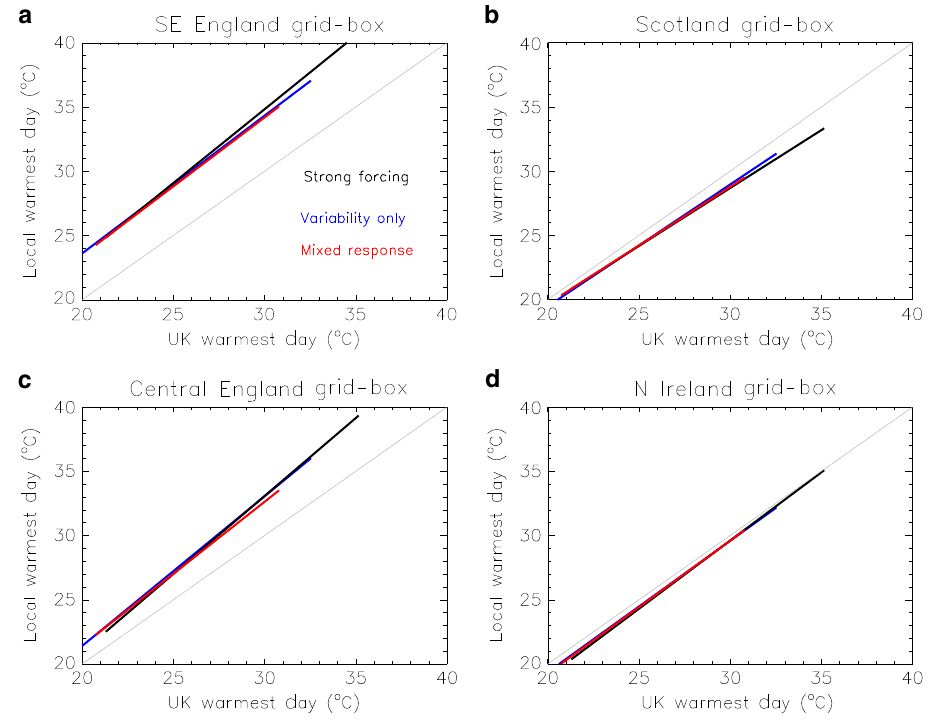
Fig. 4 Transfer functions derived from the 16 models. Functions computed with simulations with all external forcings and training periods 2020 – 2100 (strong forcing) and 1960 – 2019 (mixed response) are shown in black and red, respectively. Functions from simulations with natural forcings only (variability only) are shown in blue. Each panel corresponds to a different grid-box.